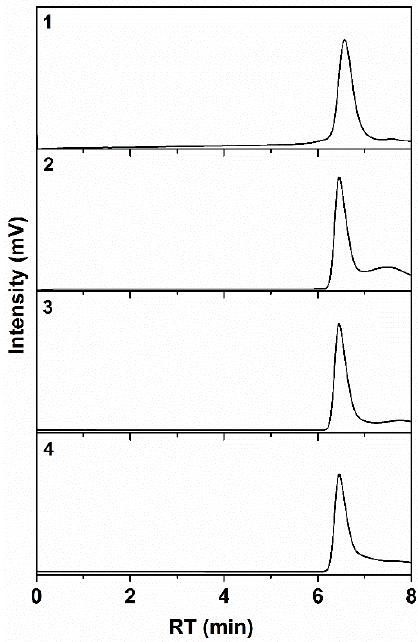
Figure 6. GPC curves of star-shaped CPh6-PEtOx ( 1 ), CPh6-PiPrOx ( 2 ), CPh6-PEtOz ( 3 ), and CPh6-PiPrOz ( 4